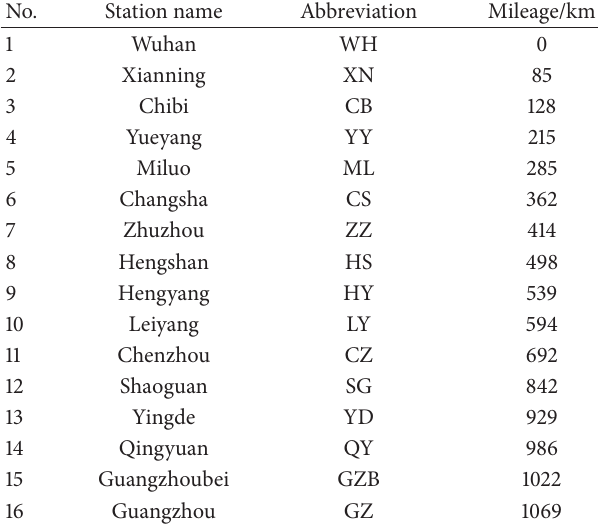
Table 1: Stations and mileages of Wu-guang high-speed